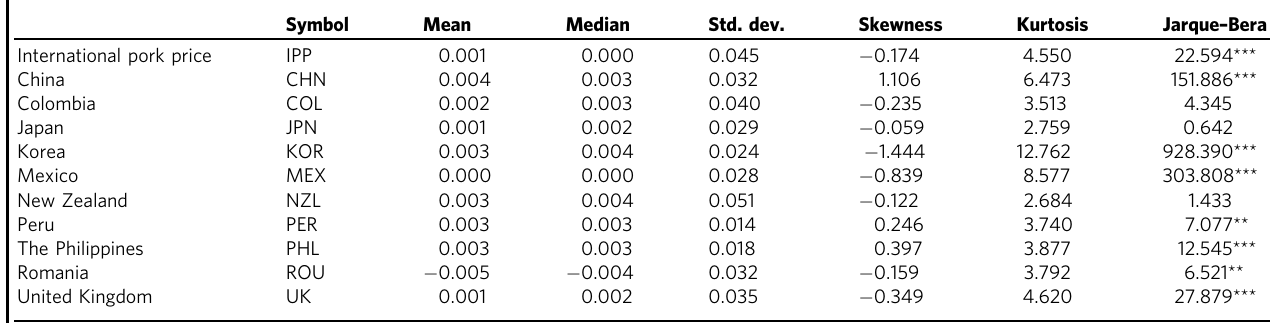
Table 1 Summary statistics for pork price returns.